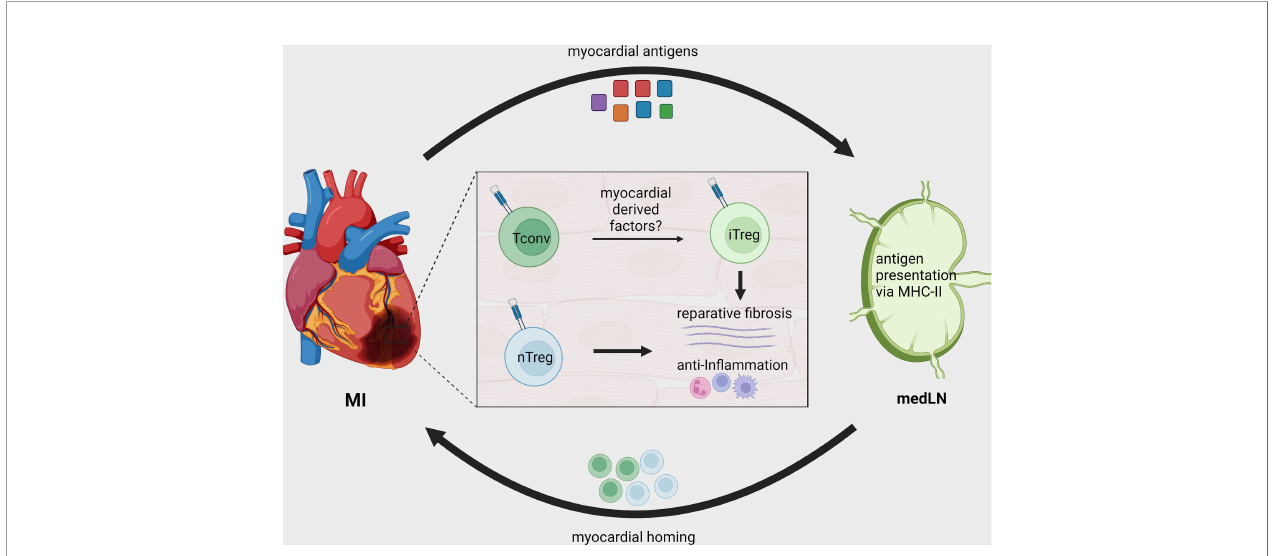
FIGURE 2 | Treg recruitment and in situ conversion during MI. After MI, cardiac autoantigens, including MYHCA, are drained to local MedLN and presented to CD4 + T-cells via the MHC-II molecule. Naturally existing thymus derived Tregs (nTreg) and conventional T-cells are activated in the MedLN after MI and migrate to the infarcted tissue. The myocardial immune crosstalk induces myosin-speci fi c T-cells to acquire an induced regulatory phenotype (iTreg). Both induced and naturally occurring Tregs contribute to tissue repair by modulating local in fl ammatory response and fostering tissue fi